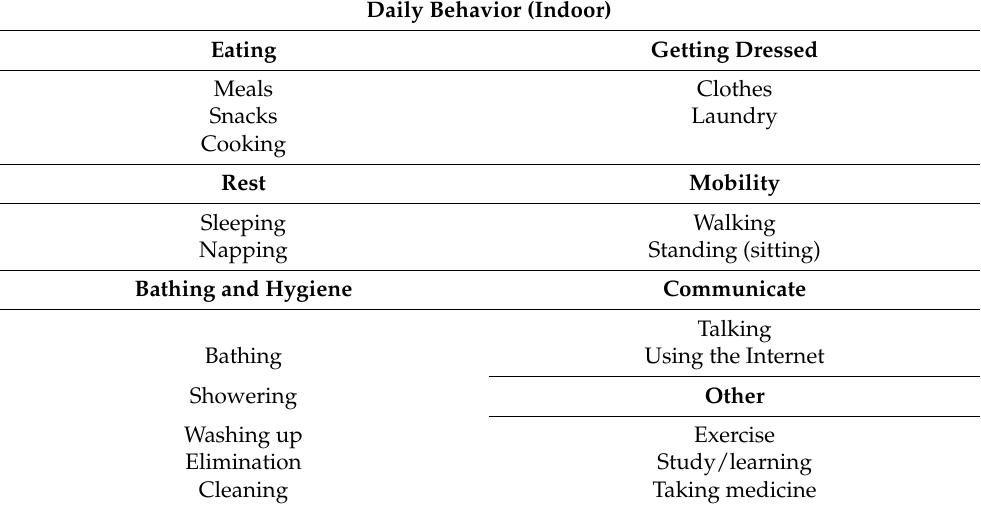
Figure 1. Smart home living lab (w/tour path). Table 1. Resident